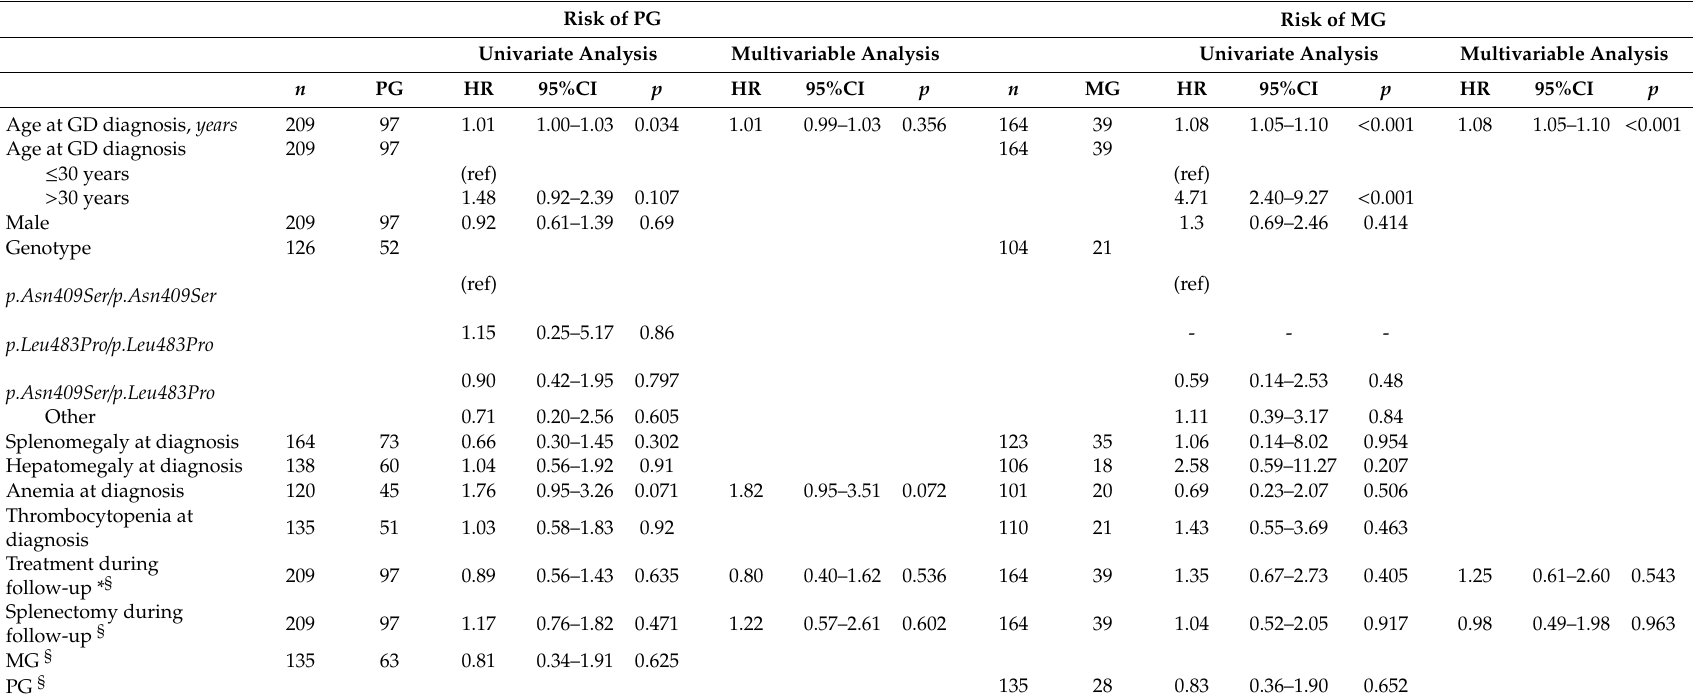
Table 2. Cox proportional-hazards analysis of risk of PG or MG with GD. Risk of